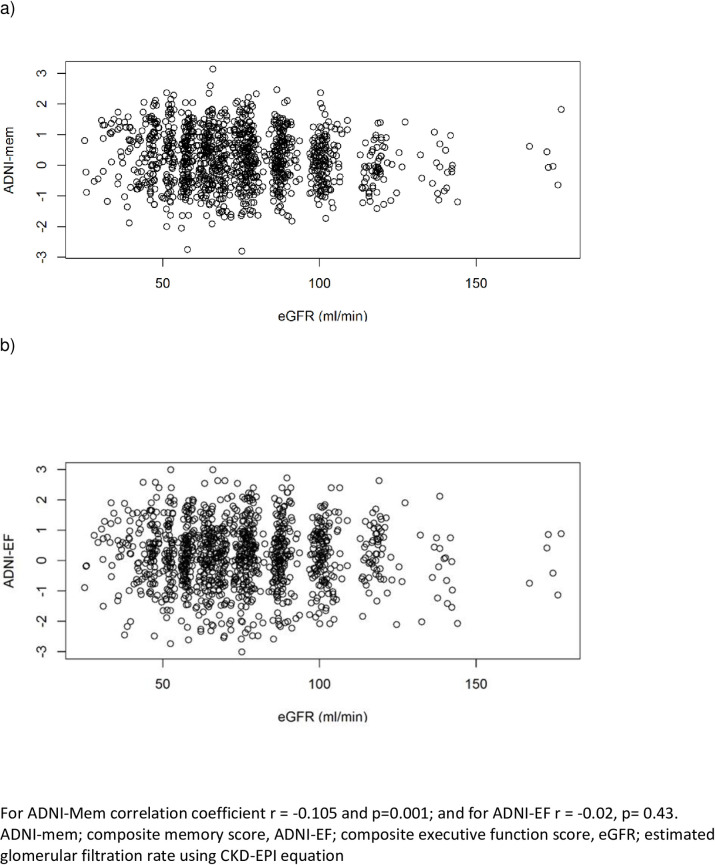
Scatterplot showing unadjusted correlation for a) ADNI-mem and b) ADNI-EF scores (y axis) and GFR (x-axis).